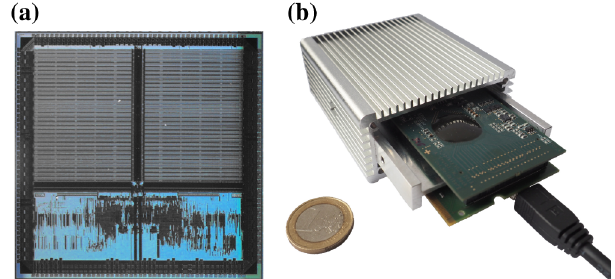
FIG. 1. The neuromorphic-hardware system Spikey. (a) Photo- graph of the Spikey chip (size 5 × 5 mm 2 ). It comprises analog circuits of 384 neurons and 98304 synapses, is highly config- urable, and emulates neural-network dynamics with a speed-up of 10 4 with respect to biological real time. (b) Photograph of the partly cased Spikey system, carrying the Spikey chip (covered by a black round seal) and conventional memory. The system is connected to the host computer via USB 2.0, consumes 6 W of power in total and less than 1 nJ per synaptic transmission (see Supplemental Material, Sec. I